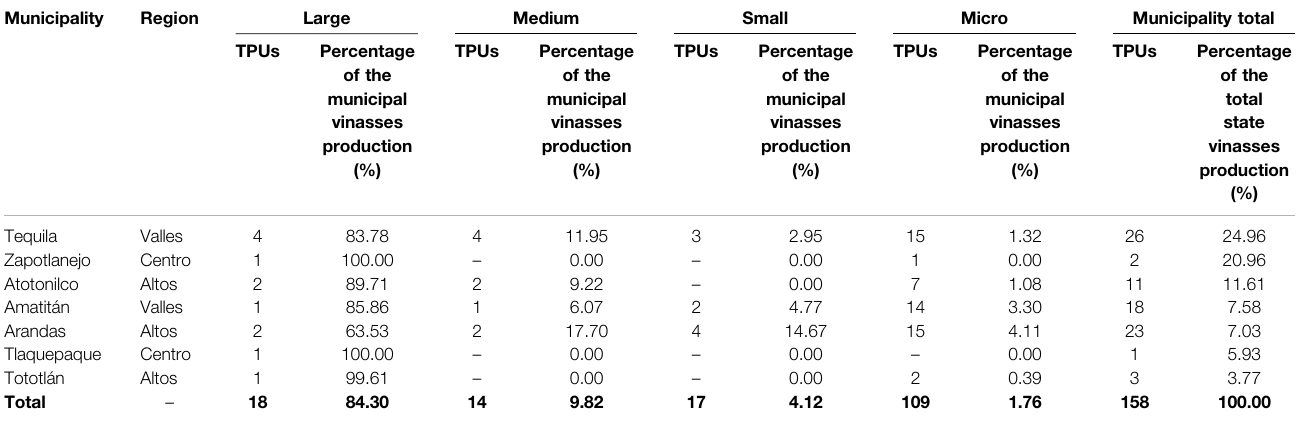
TABLE 5 | TPUs and vinasses production within the municipalities responsible for 80% of the vinasses within the state of Jalisco.